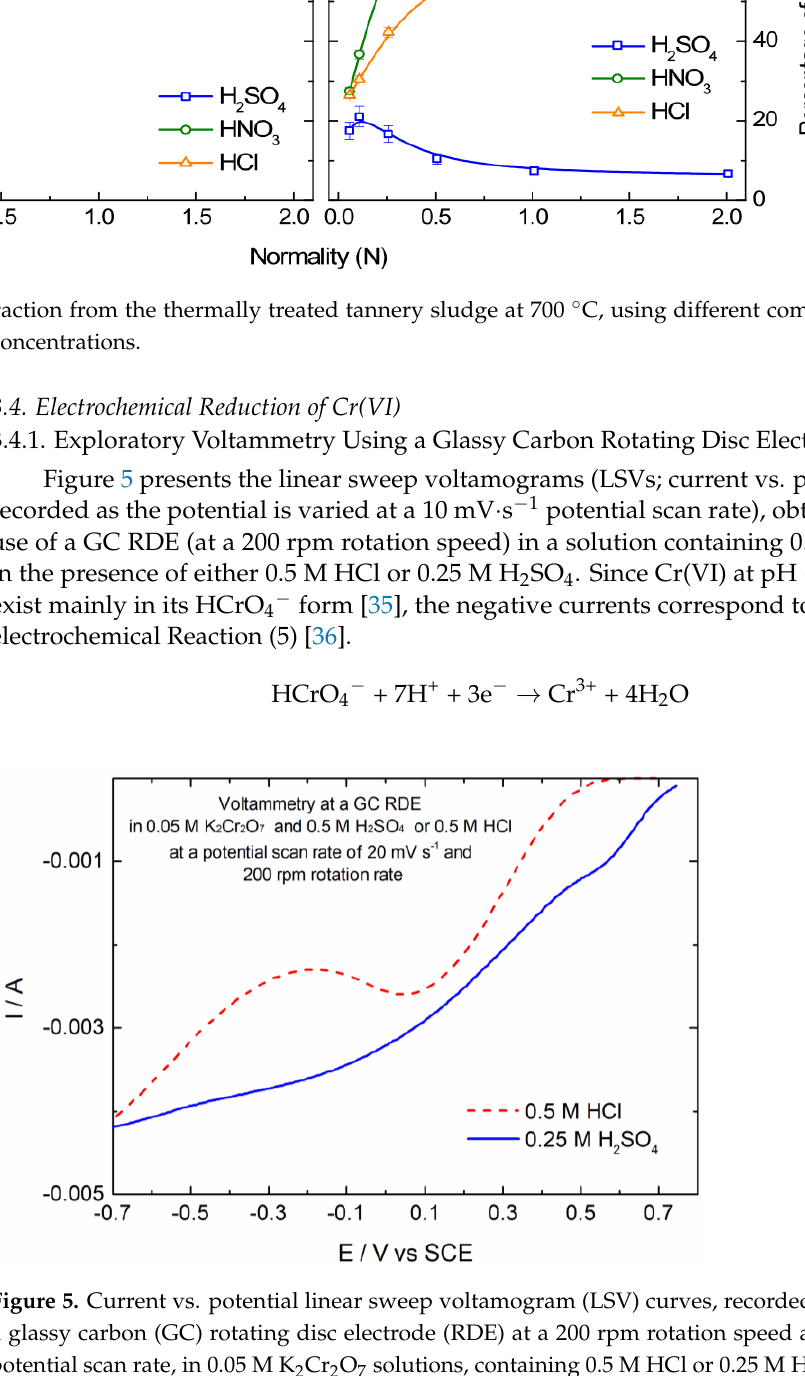
Figure 5. Current vs. potential linear sweep voltamogram (LSV) curves, recorded with the use of